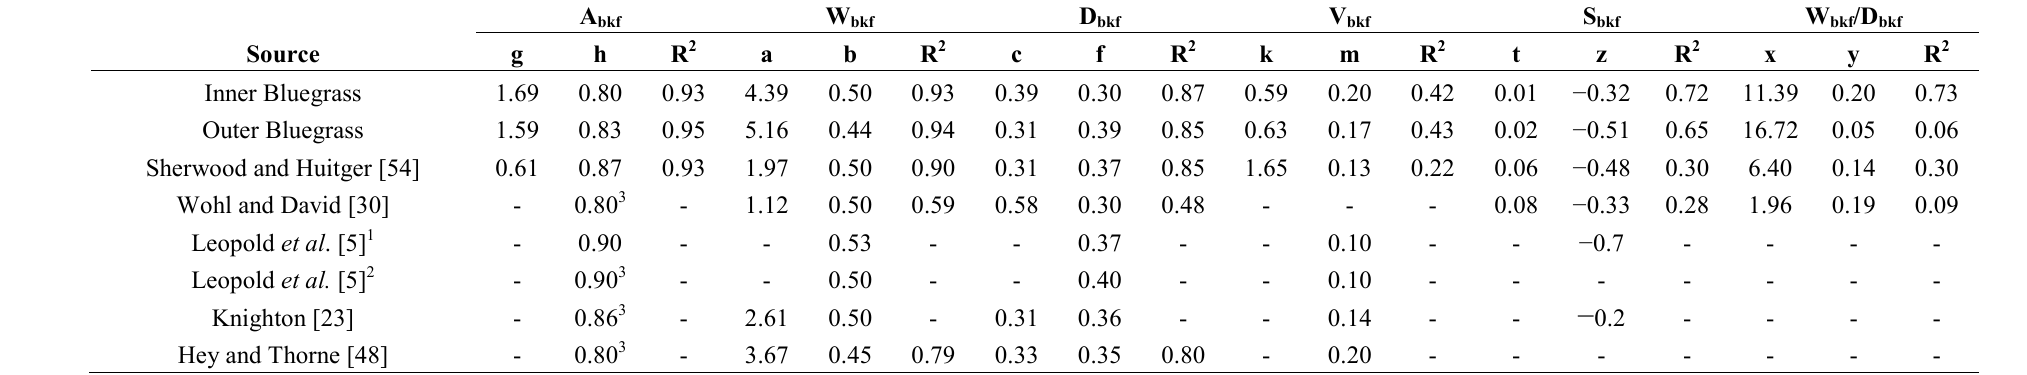
Table 3. Hydraulic geometry curves for equations 1, 2, 3, bankfull slope (S Q represents bankfull discharge (m 3 s −1 ), A bkf